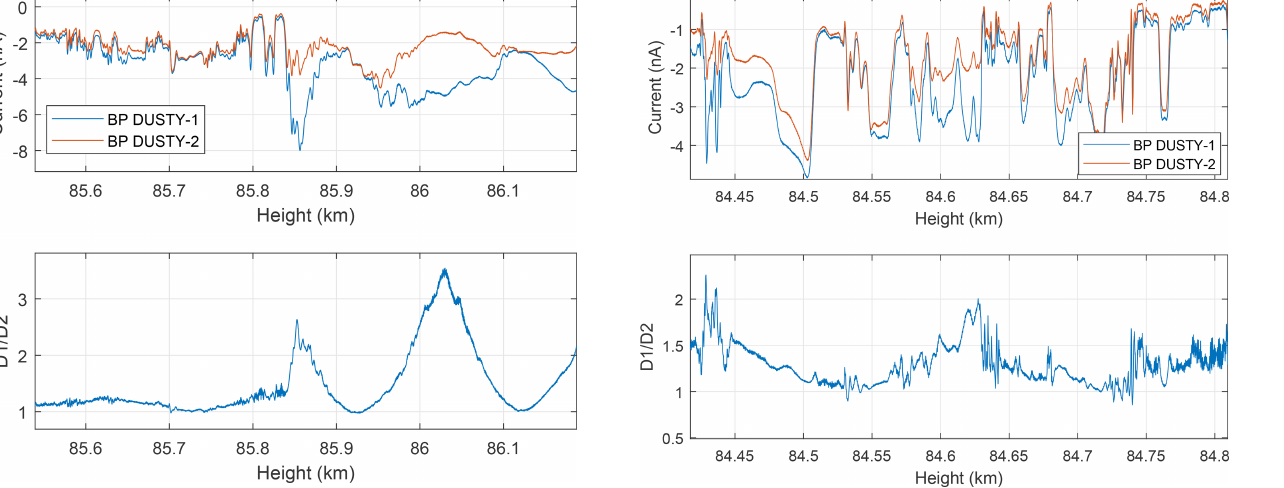
Figure 6. Magnification of region with relatively strong probe cur- rents below disagreement onset. A generally good agreement is found down to the lowest height scales ( ∼ 10cm), which is justi- fied by the D 1 /D 2 ratio being near